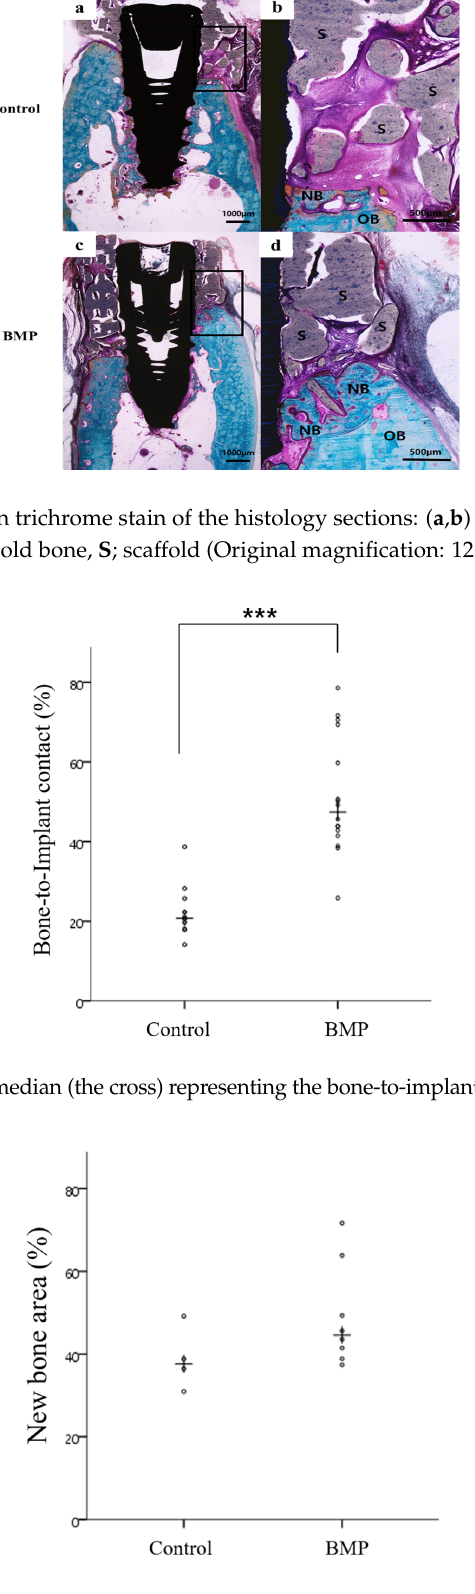
Figure 8. Hematoxylin-eosin stain of the histology sections: ( a , b ) Control group; ( c , d ) BMP group.